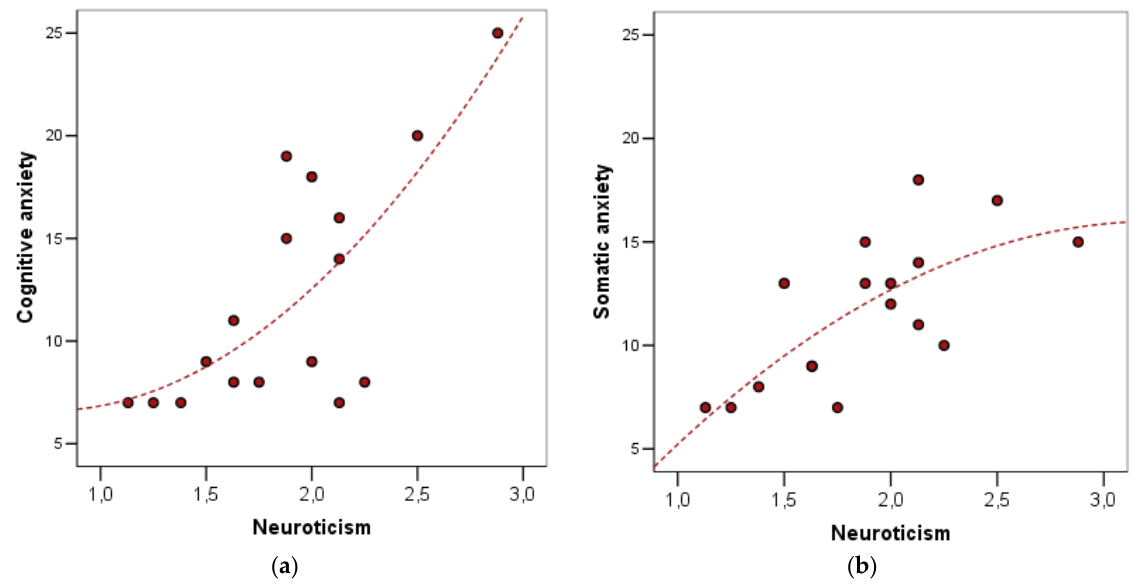
Figure 2. Relation between neuroticism level (measured with the BFI) and: ( a ) cognitive anxiety; ( b ) somatic anxiety (measured with the CSAI-2R).